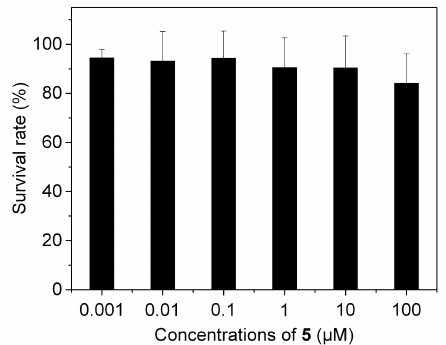
Figure 2. Cytotoxicity of 5 against MCF-7 cells.